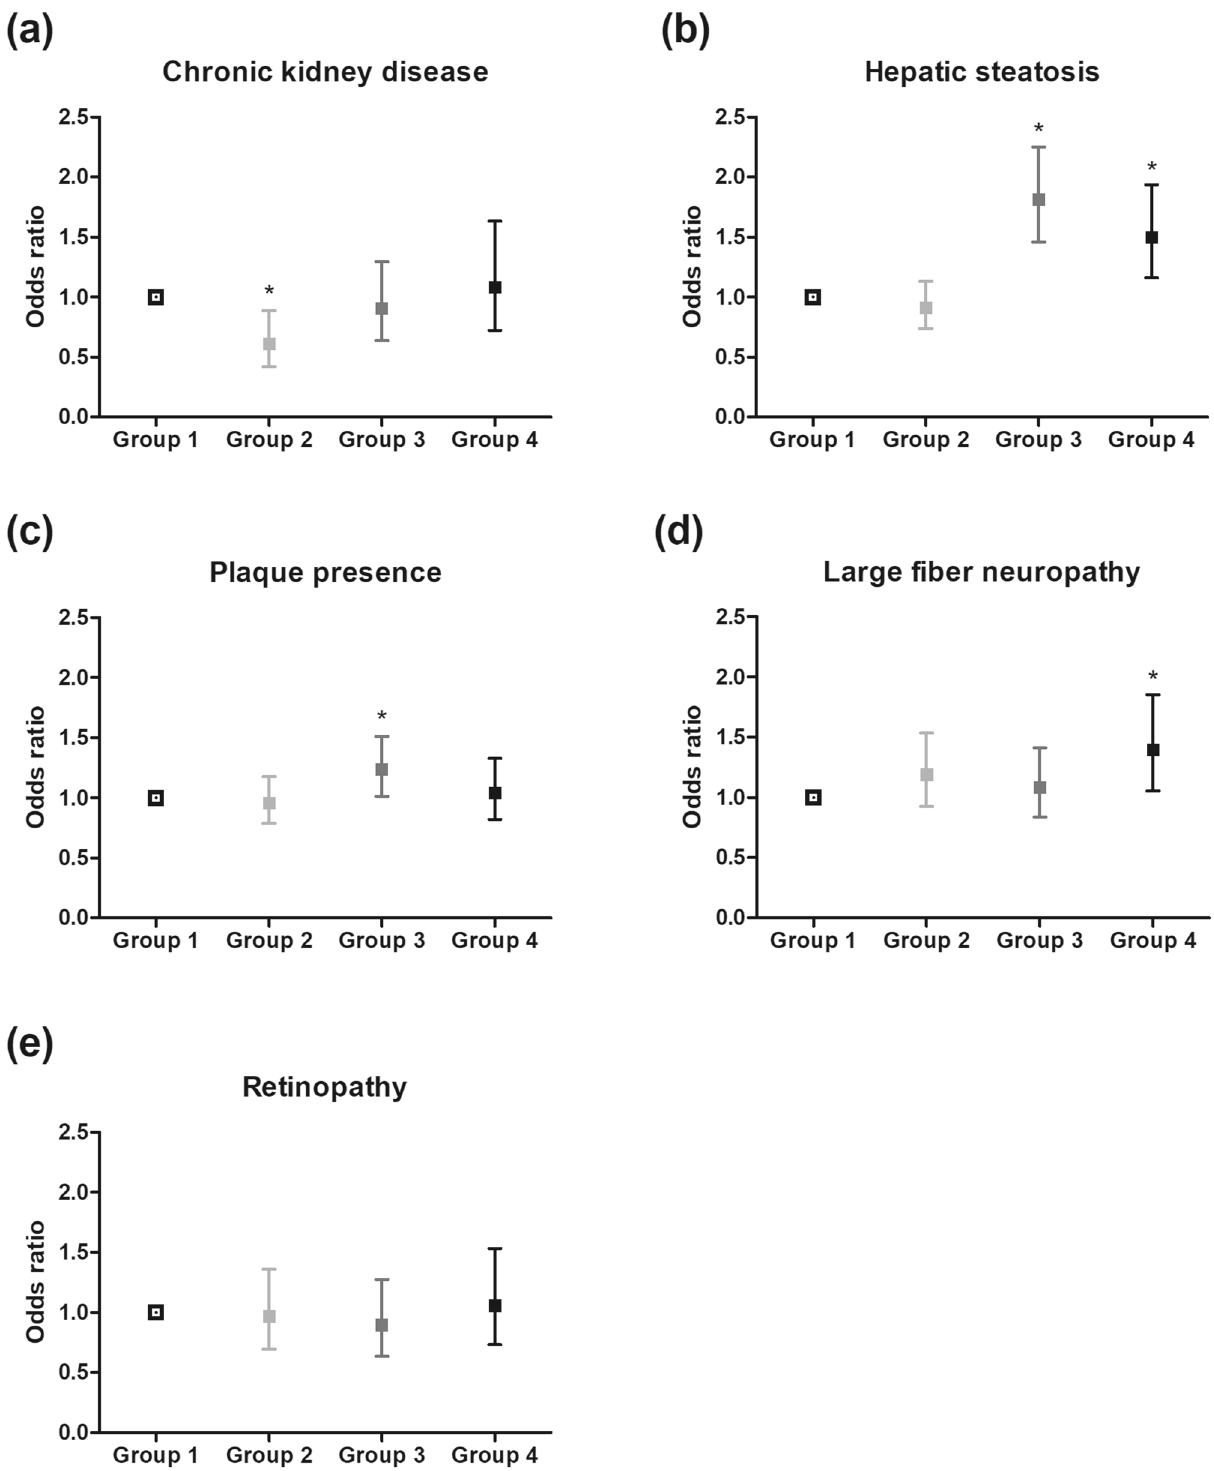
Figure 1. Odds of accompanying diabetic complications or hepatic steatosis by group according to insulin sensitivity and beta-cell function. Odds ratios of ( a ) chronic kidney disease (eGFR < 60 mL/min/1.73 m 2 ), ( b ) hepatic steatosis, ( c ) plaque presence, ( d ) large fiber neuropathy, and ( e ) diabetic retinopathy. The results were adjusted for age, sex, diabetes duration, systolic blood pressure, diastolic blood pressure, time of enrollment, method of insulin measurement, BMI, HbA1c levels, LDL cholesterol levels, eGFR (not included in the analysis depicted in a ), statin use, smoking status, alcohol consumption, and physical activity. Group 1. Reference (mild insulin resistance and beta-cell dysfunction) group. Group 2. “Severe beta-cell dysfunction” group. Group 3. “Severe insulin resistance” group. Group 4. “Severe insulin resistance and beta-cell dysfunction” group. BMI body mass index, LDL low-density lipoprotein, eGFR estimated glomerular filtration rate. *p < 0.05 versus group